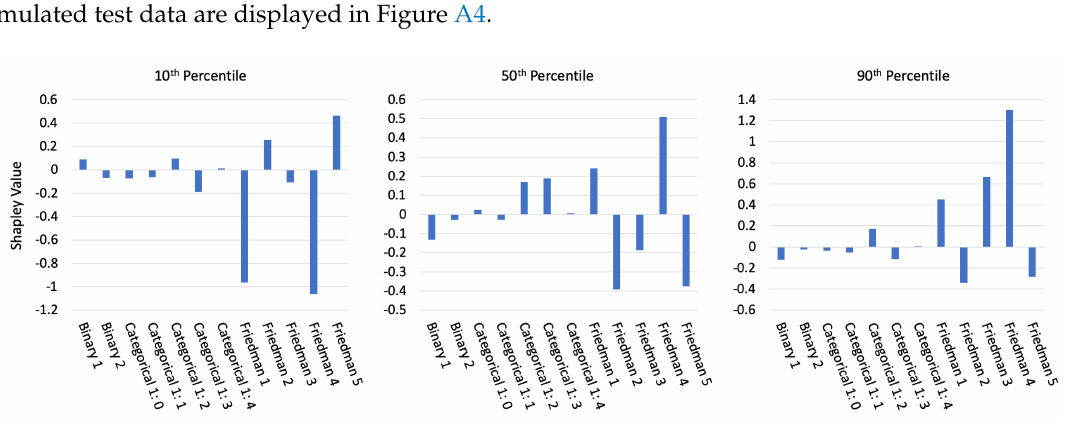
Figure A4. Tree SHAP values for three instances across selected percentiles of g MGBM ( X ) for the simulated test data.